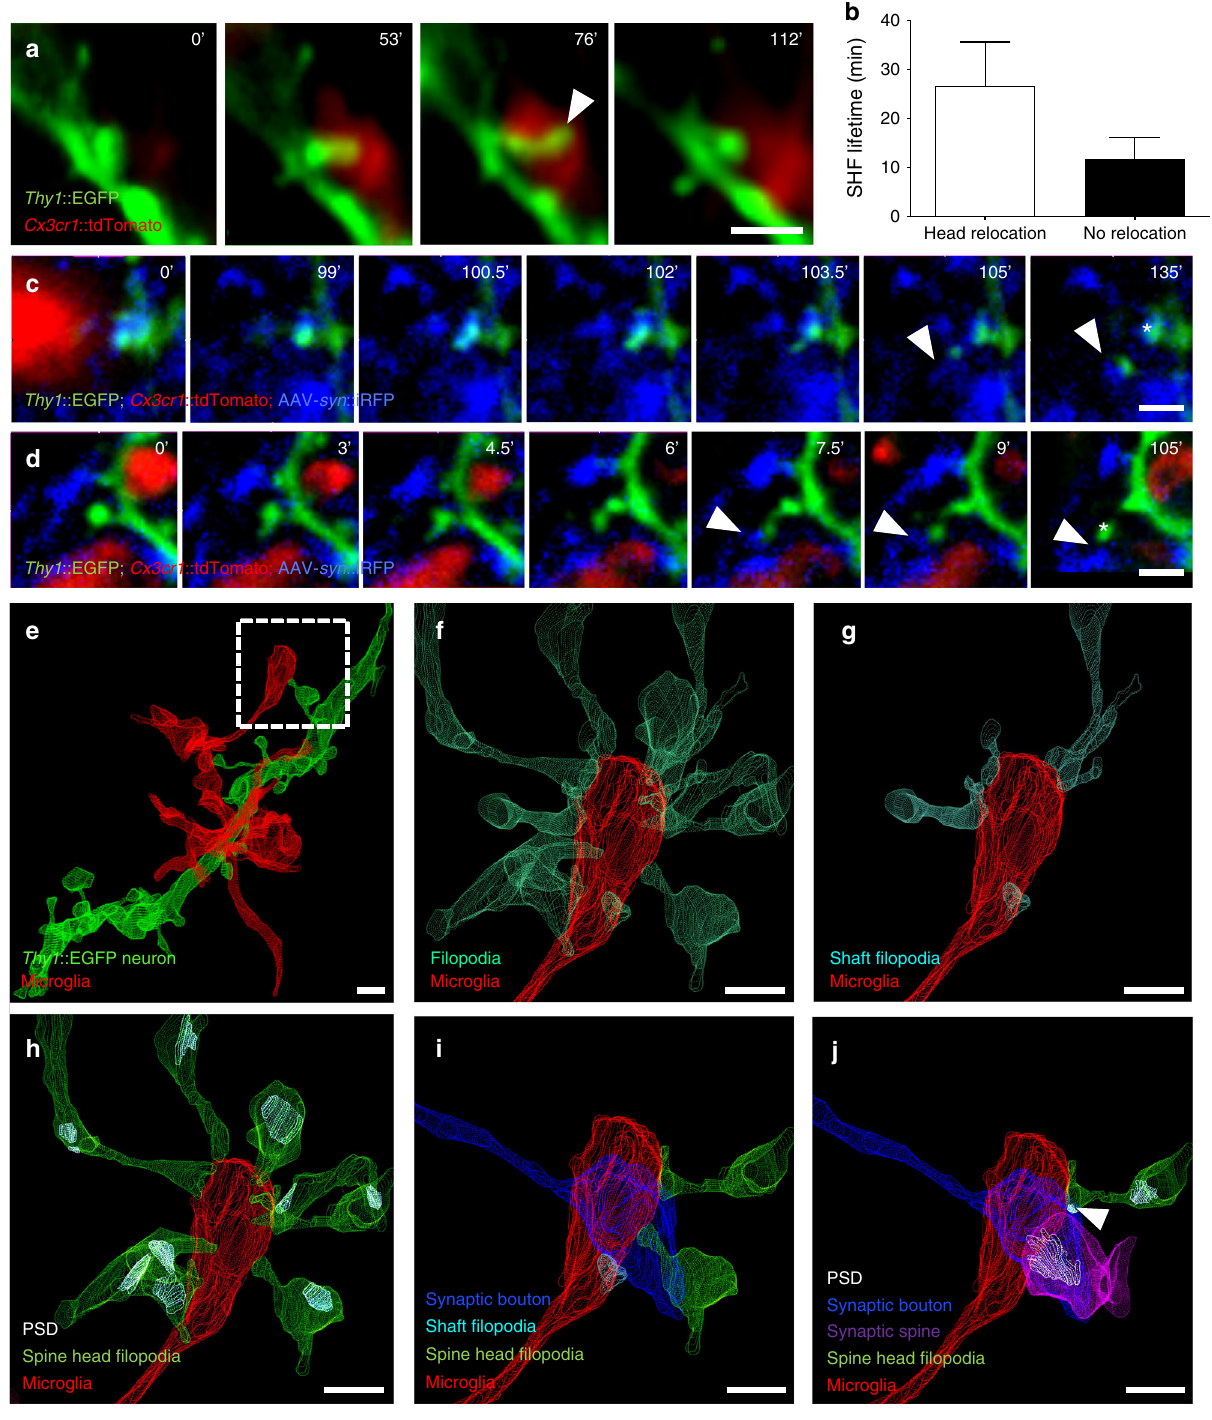
Fig. 7 Spine head fi lopodia-associated synapse remodeling. a Representative time sequence images of a spine head relocating to the tip of the SHF following its induction by microglia. b Quanti fi cation of SHF lifetime revealed more stable fi lopodia following relocation ( n = 5 relocating SHF vs 16 non- relocating, analyzed from 3 organotypic slice cultures, error bars are mean + SEM). c , d SHF making a stable contact with a neighboring bouton (arrowhead). In c the spine persists at its original location (star), whereas in d the spine relocates to the newly contacted bouton (star). e Example of microglial process in contact with a spine extending a SHF (dotted box) as identi fi ed and visualized by CLEM. Further examination of the fully segmented EM dataset revealed f multiple fi lopodia extending toward the microglial process, of which g a few were simple fi lopodia and h the majority originated from mature spines bearing postsynaptic-densities (PSDs). It is noteworthy that the microglial process is in intimate contact with a presynaptic bouton and i several of the SHFs contact the same bouton, j one of which has formed an immature PSD (arrowhead, Supplementary Fig. 5) resulting in the formation of a multiple-synapse bouton. Scale bars: 1 µ